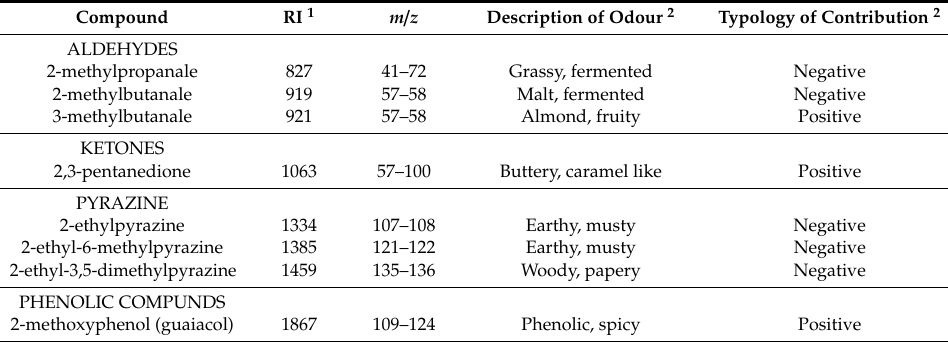
Table 4. Key odorants detected in EC brewed by